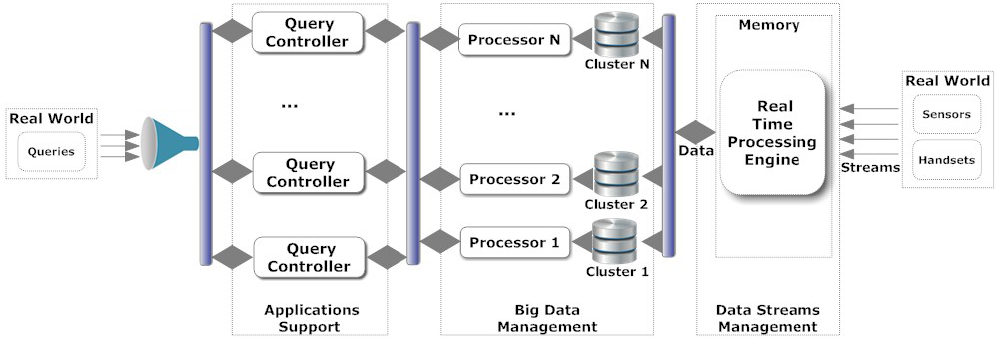
Figure 1. The architecture of our